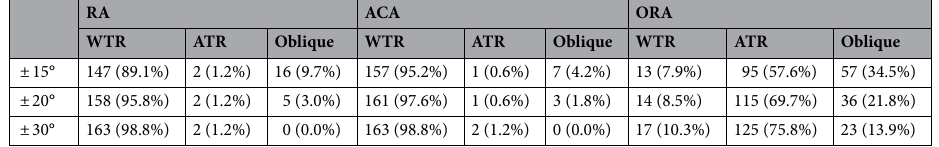
Table 1. The distribution of RA, ACA, ORA with different classification of astigmatism axes in current study.